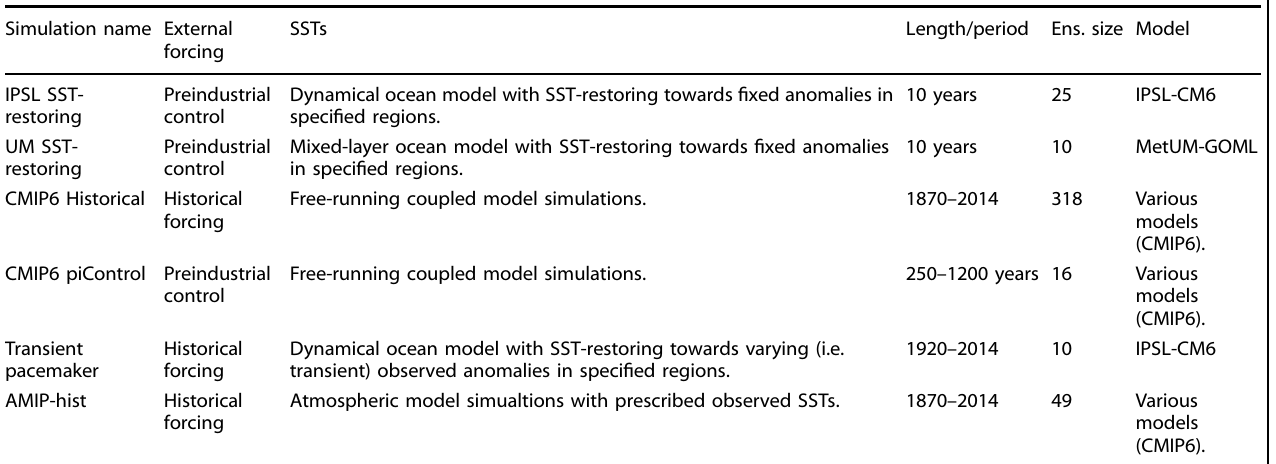
Table 1. Summary of the simulations analysed in this